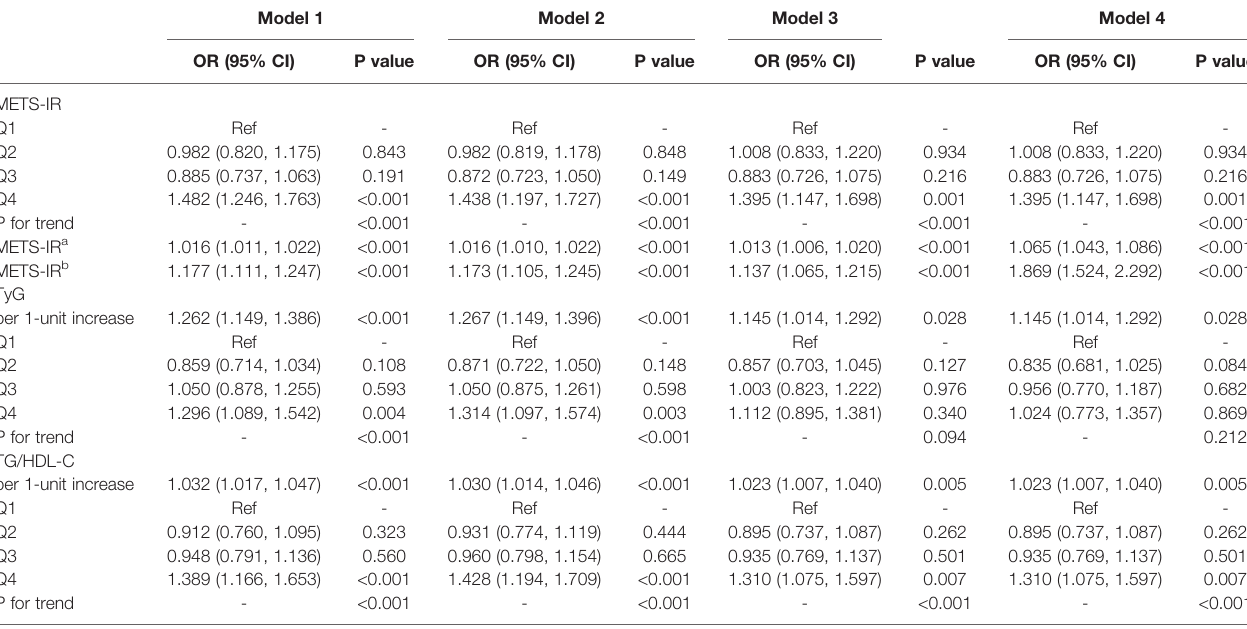
TABLE 2 | Multivariate logistic regression analyses of associations between METS-IR, TyG, TG/HDL-C and SC-MI.